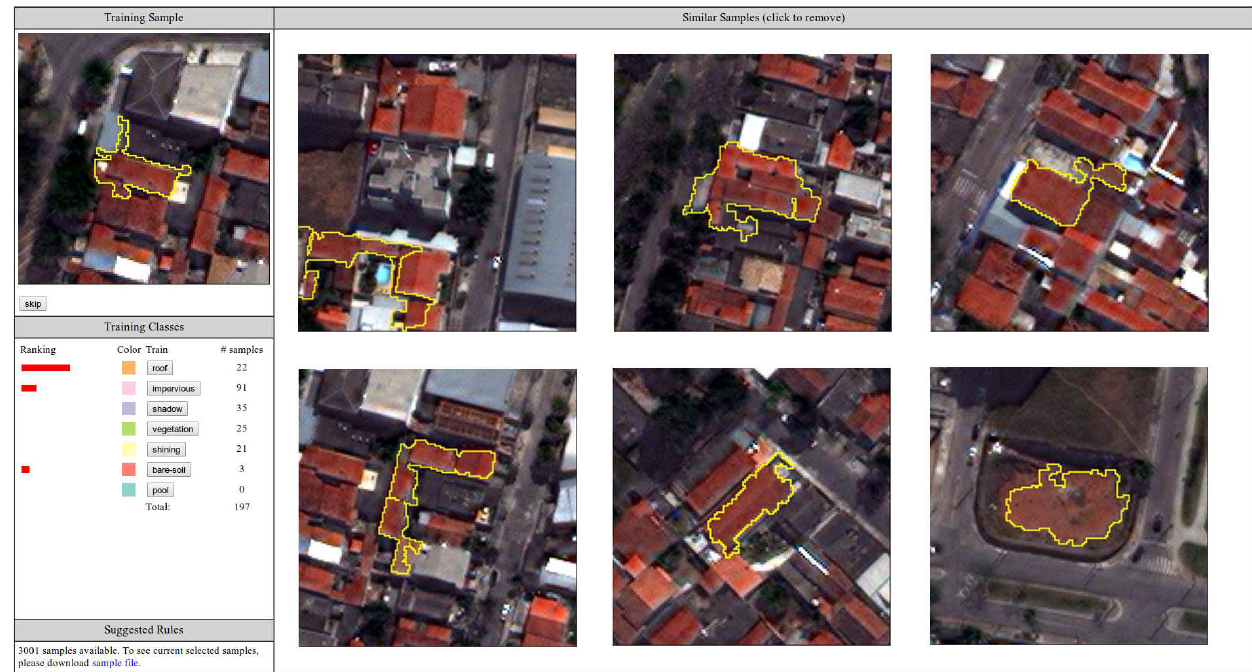
Figure 6. A ranking of similarity between the target and current sample selection. In this example, the target is more similar to class roof